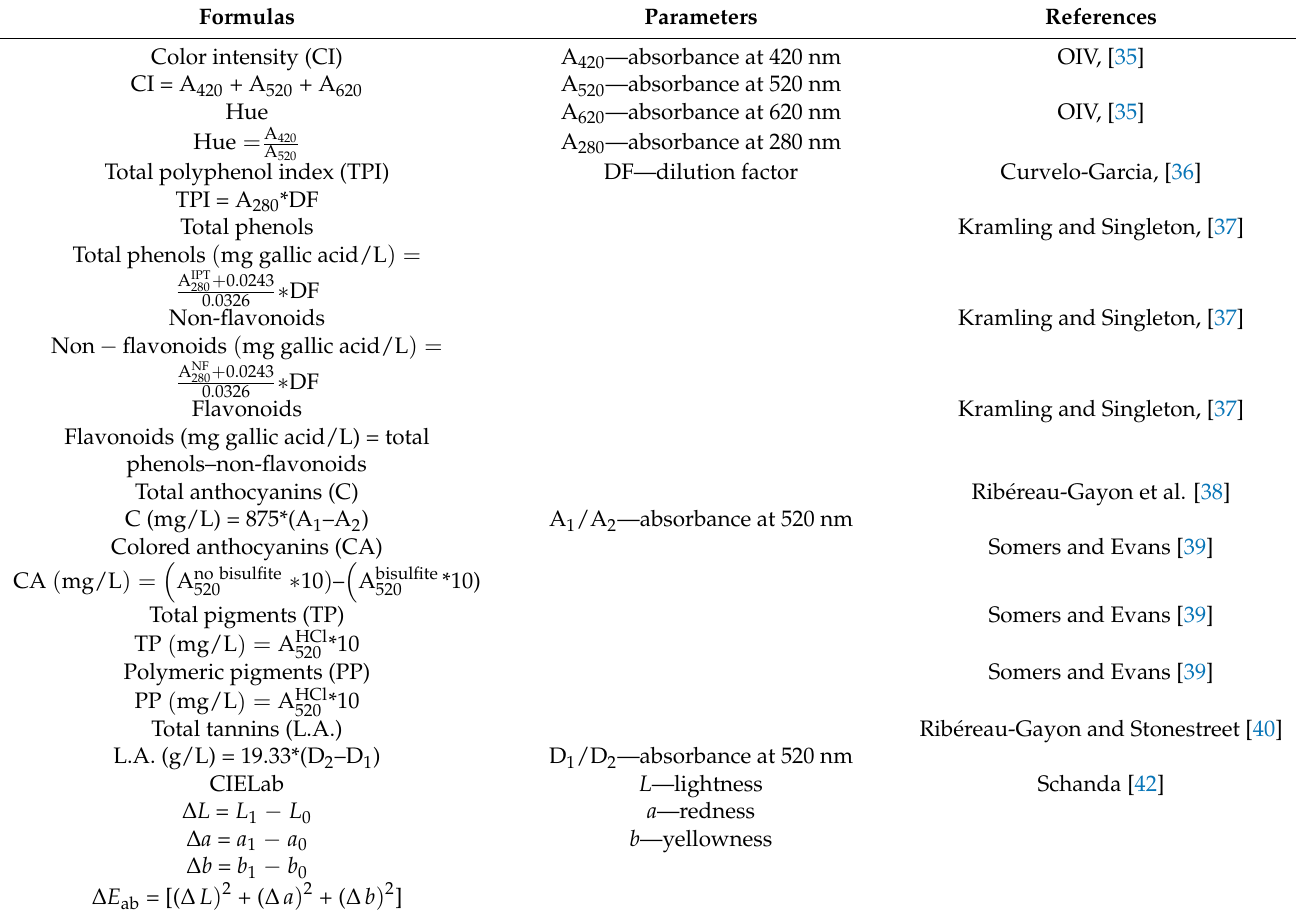
Table 2. Formulas for phenolic composition and chromatic (CIELab)